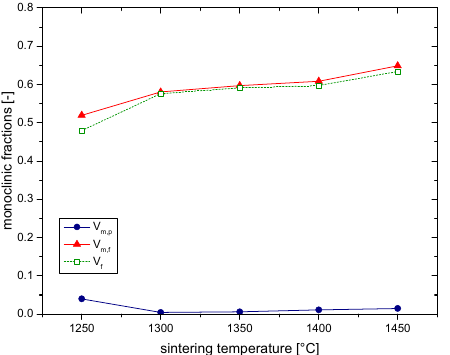
Figure 8. Monoclinic contents in polished / fractured surface and transformability determined by XRD.